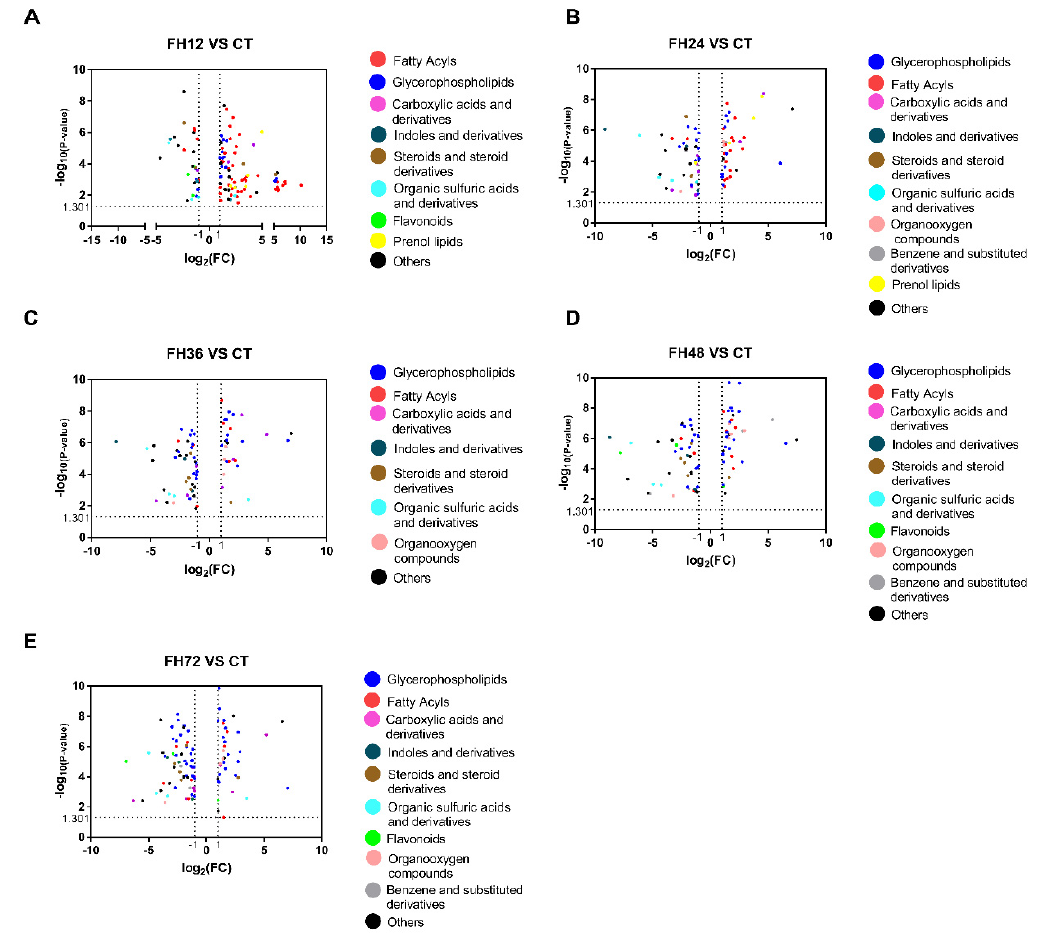
Figure 5. Volcano plots changed at 12 ( A ), 24 ( B ), 36 ( C ), 48 ( D ), and 72 h ( E ) compared with the non-fasting group.